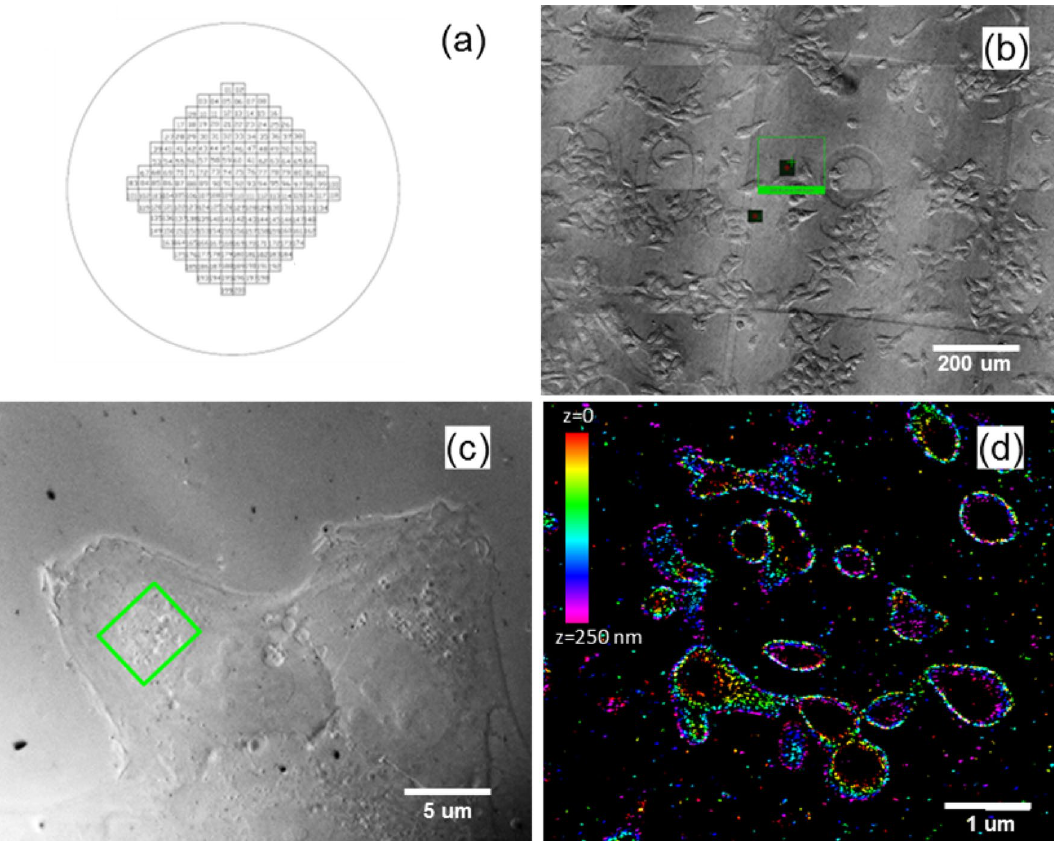
Figure 2. Schematic of 25 mm diameter photoetched coverslip ( a ); Brightfield image of the sample under prescan mode (low magnification) of iPALM system ( b ). Brightfield image of the target ROI under iPALM mode (high magnification) of iPALM system ( c ). color coded 3D iPALM fluorescence imaging within 250 nm z depth ( d